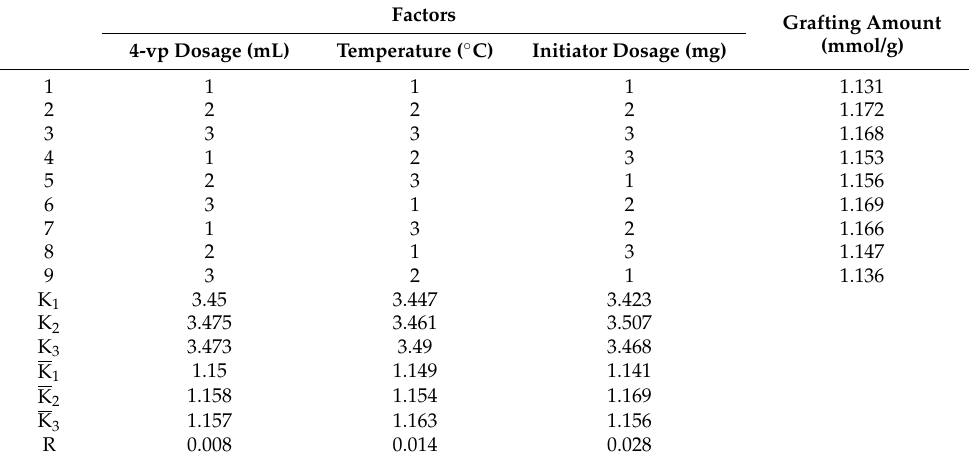
Figure 14. Orthogonal experiment result. Table 3. Analysis of orthogonal test results.